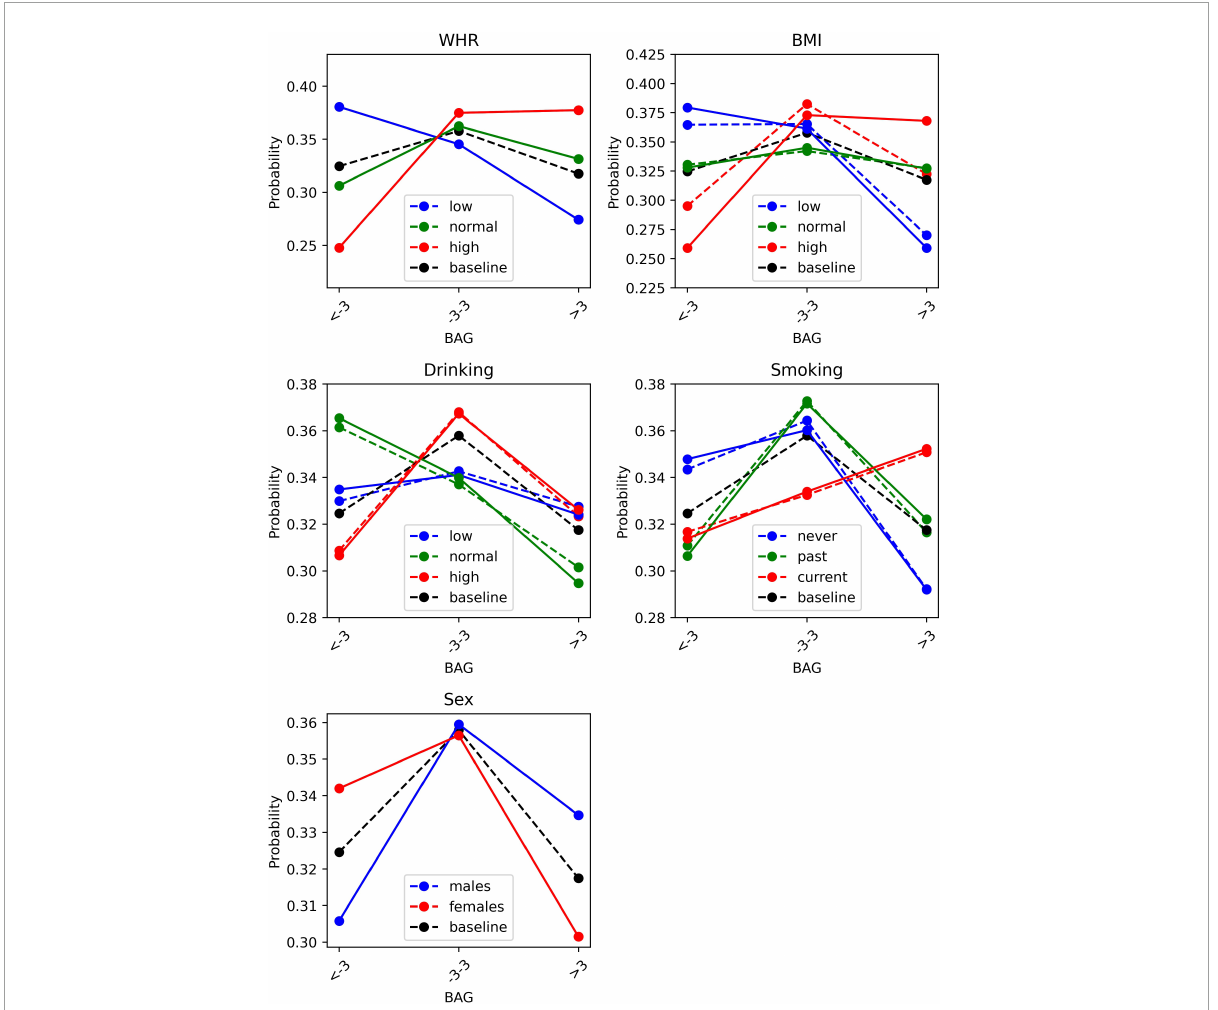
FIGURE2 BAG distributions when observing (plain lines) or intervening (dashed lines) on the cardiovascular risk factors. BAG, brain age gap; BMI, body mass index; WHR, waist-to-hip